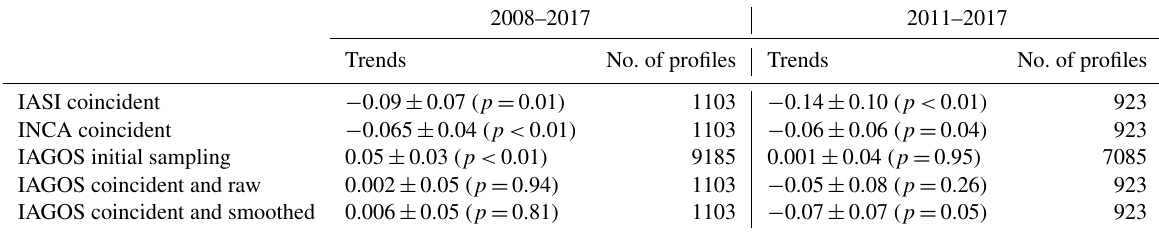
Table 6. Trends calculated for the 3–6km O 3 columns in Europe using a subset of coincidence profiles of IASI, IAGOS, and INCA (see the text for the details on the coincidence criteria) and using the initial set of IAGOS profiles. The IAGOS trends for the coincident set of profiles are calculated from the raw and the smoothed profiles. The trends are calculated for two periods (2008–2017 and